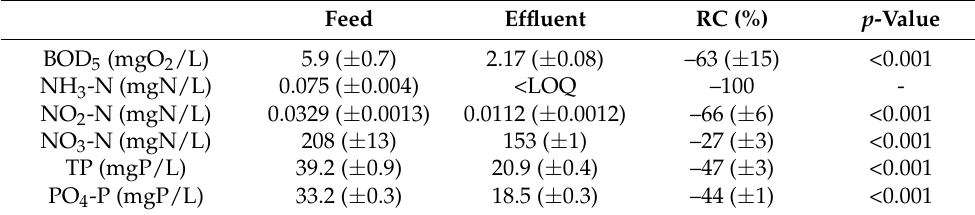
Table 4. Hydroponic treatment feed, effluent, and relative change (RC) in water quality parameters. The results are presented as triplicate ( n = 3) mean ± standard